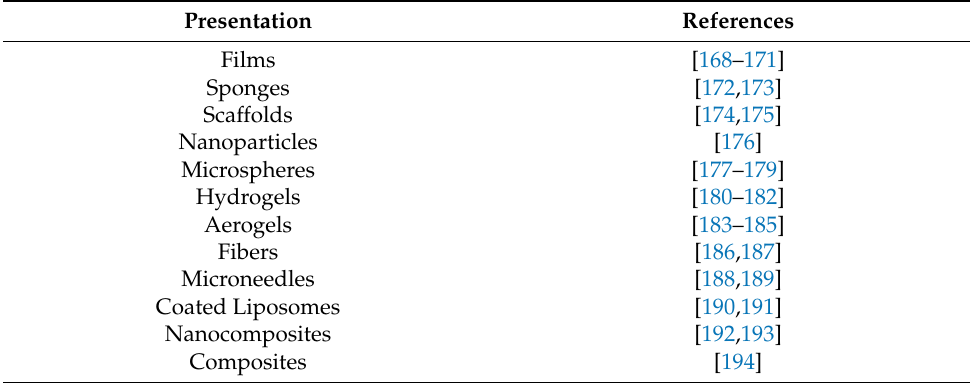
Table 5. Some examples of chitosan presentations in drug delivery.